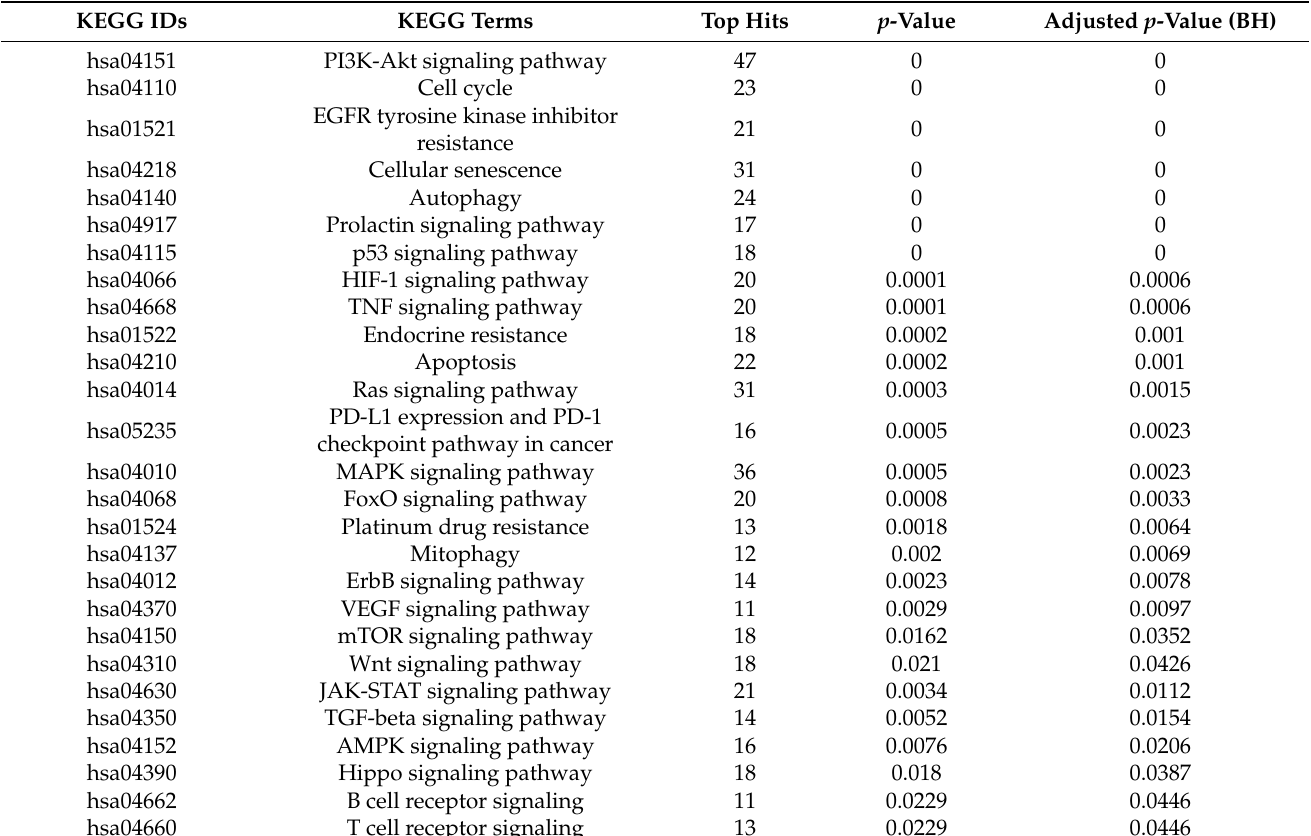
Table 2. Top significant unique KEGG pathways enriched in TNBC at the 3 (cid:48) -UTR, corresponding to the significant terms of adjusted p -value (BH) ≤